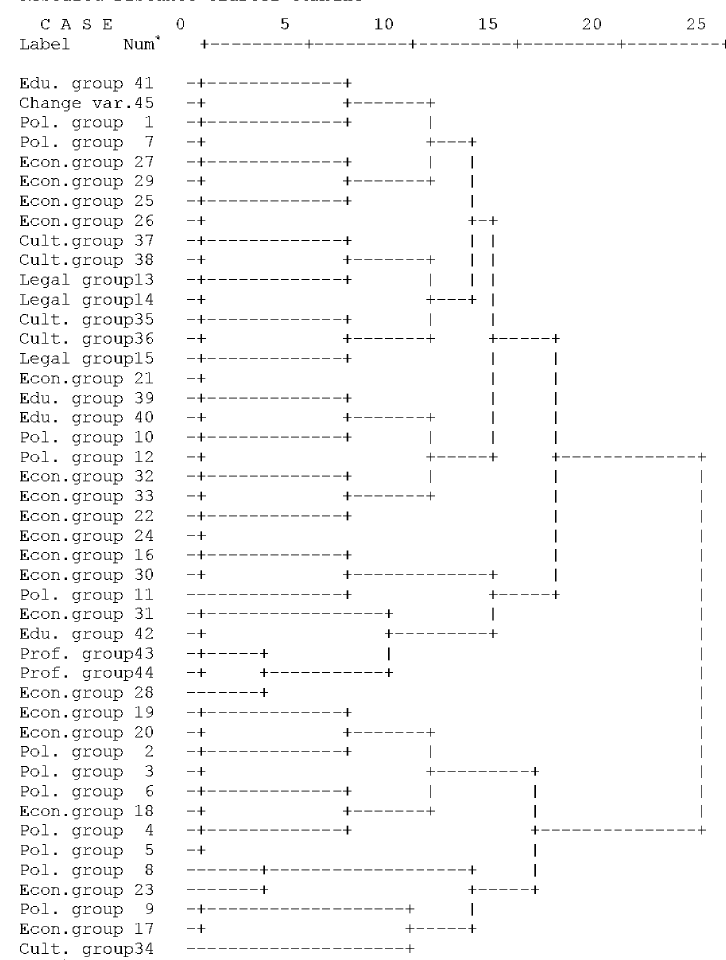
Fig. 1. Dendogram of the variables (Centroid method) Note: * the number represents the influential factor (elements or sub elements) according to